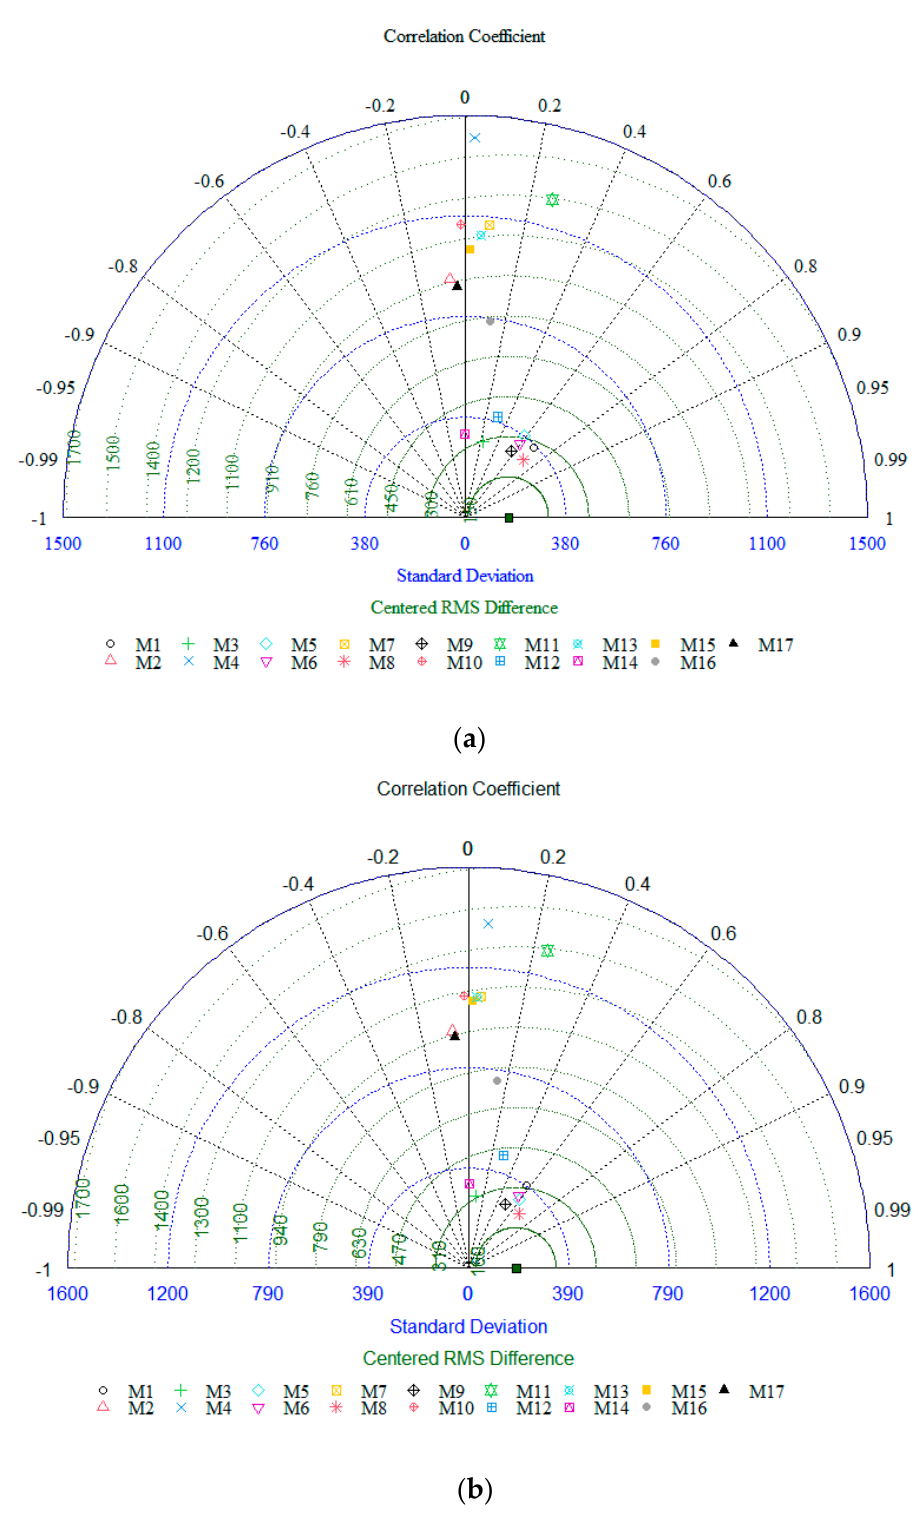
Figure 3. Grid-based comparison results for individual climate models using observed data as a reference and for the historical period (1986–2016) in ( a ) and the validation period (2006–2016) in ( b ).